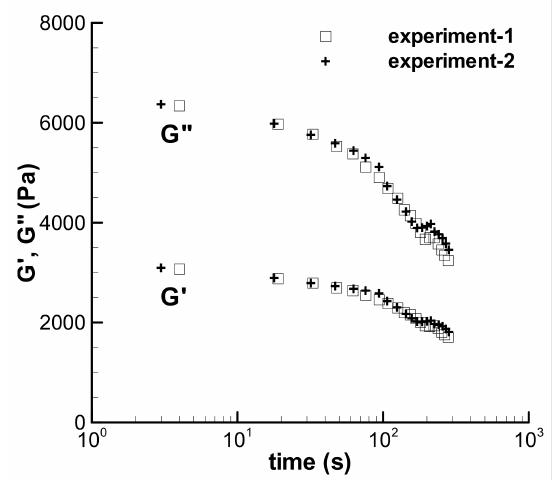
Figure 14. Dynamic time sweeps at large strain, γ = 300%, in dynamic shear mode for the LDPE melt at 150 ◦ C ( ω = 1